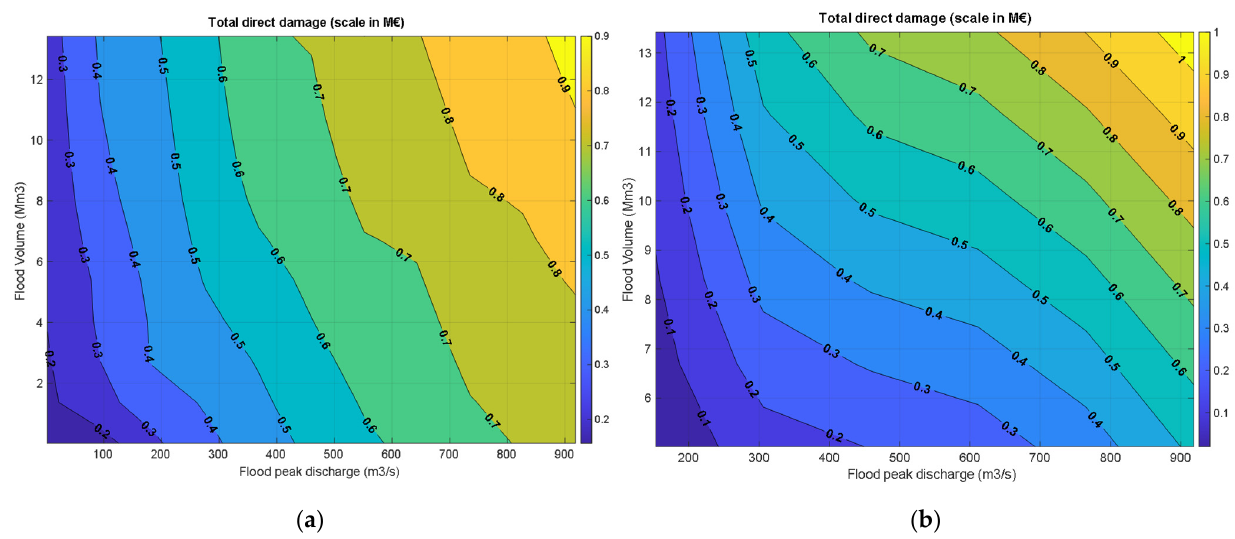
Figure 16. Spatial interpolation for the total direct damage (damage surfaces) for different IWL con- ditions: ( a ) 293.65 m a.s.l water level (IWL1); ( b ) 290.00 m a.s.l. water level (IWL2).